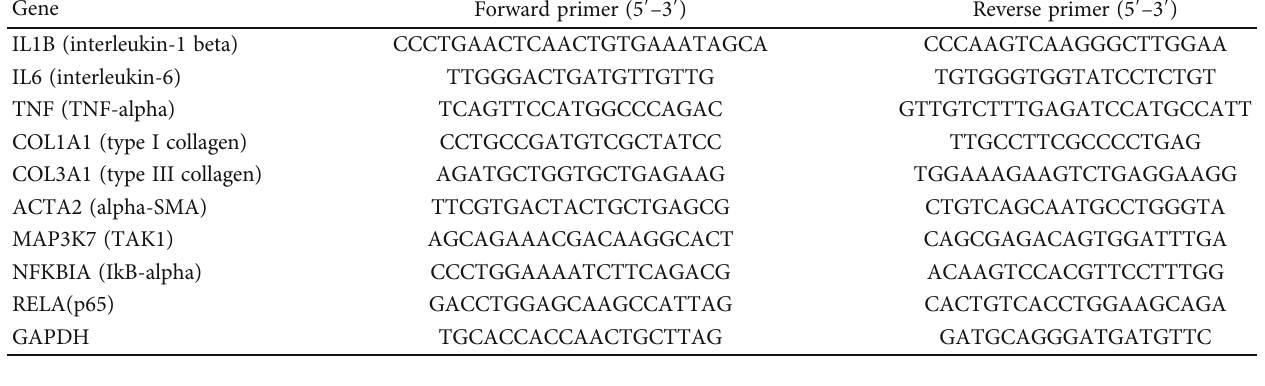
Table 1: Primer pairs list used in RT-qPCR.